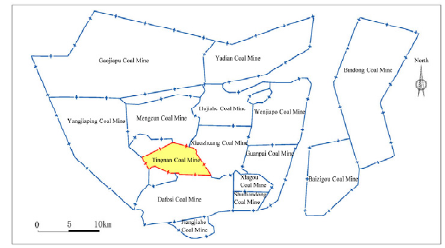
Figure 1. The location of Tingnan coal mine.